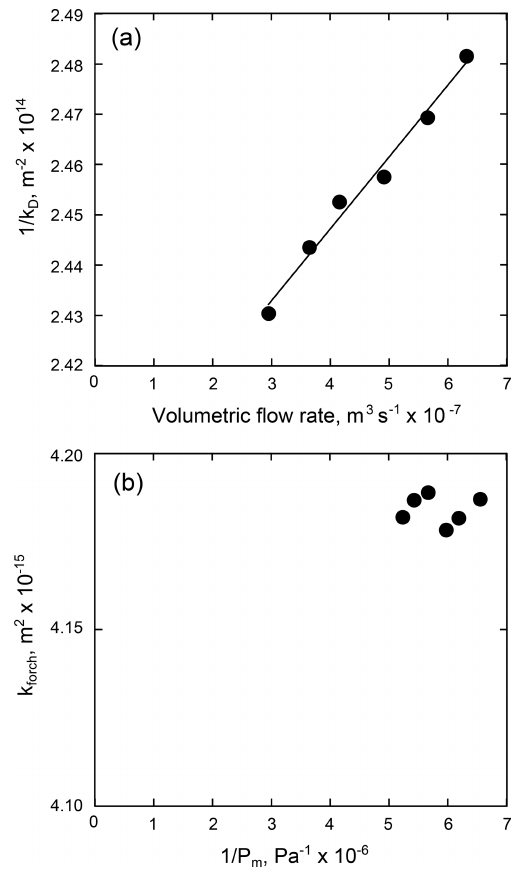
Figure 3. (a) The reciprocal of Darcian permeability, k D , as a func- tion of volumetric flow rate (for the sample 25mm in diameter and 60mm in length). The data can be well described by a positive lin- ear slope: the Forchheimer correction is therefore needed. (b) The Forchheimer-corrected permeability as a function of the reciprocal of the mean pore fluid pressure (for the sample 25mm in diameter and 60mm in length; the same experiment shown in panel a ). Since these data cannot be well described by a positive linear slope, no Klinkenberg correction is